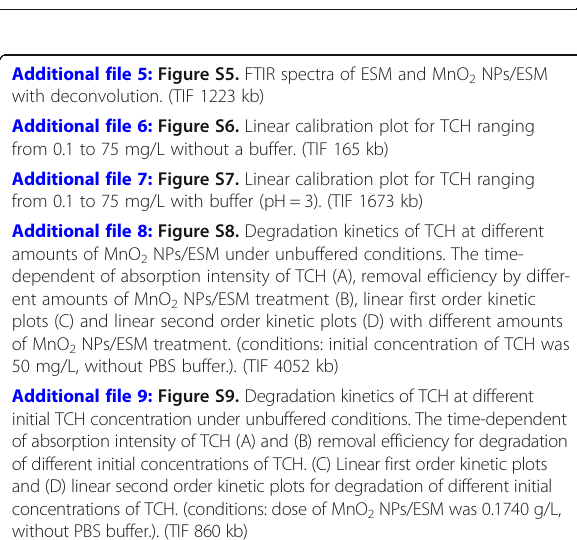
Fig. 8 Comparison of the removal efficiency of TCH by equal commercial MnO 2 powder and MnO 2 NPs/ESM under a buffered and b unbuffered